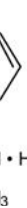
Figure 1. Chemical structure for duloxetine